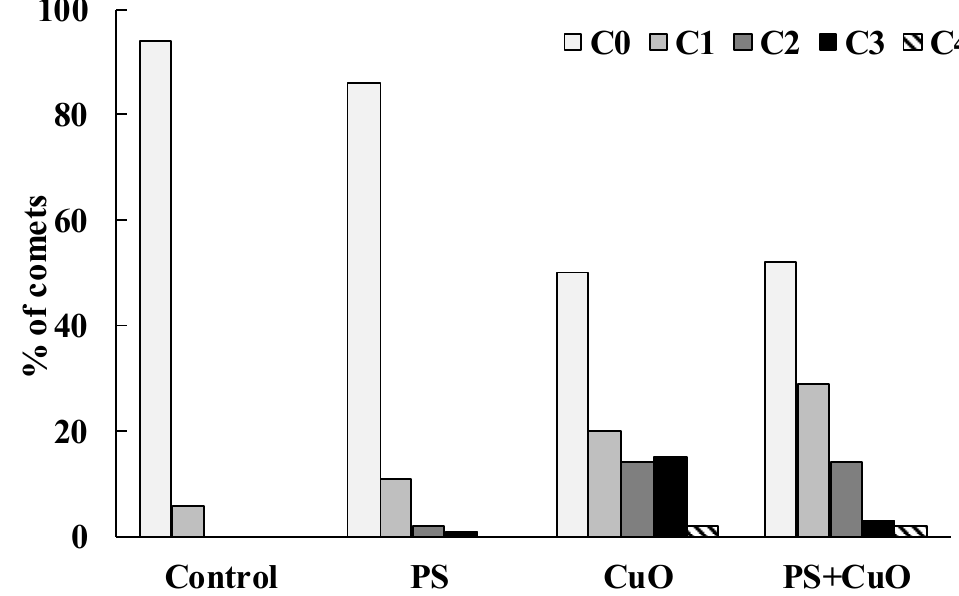
Figure 4. Cell gradation by DNA damage class in the digestive gland tissues of control and experimental groups (n = 30 and n = 1500, respectively).